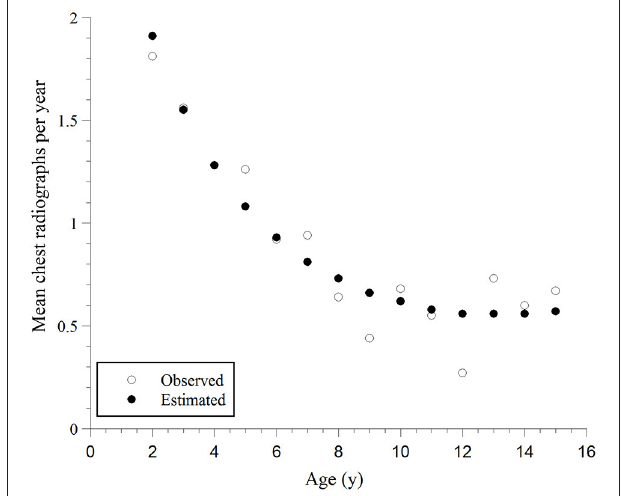
FIGURE 1 | Mean observed rates of chest radiographs per year and the corresponding predicted rates, estimated using the negative binomial regression model vs. age and age 2 ; the model fitting curve is: Rate of chest radiographs = Exp{1.124–0.259 Age + 0.010 Age 2